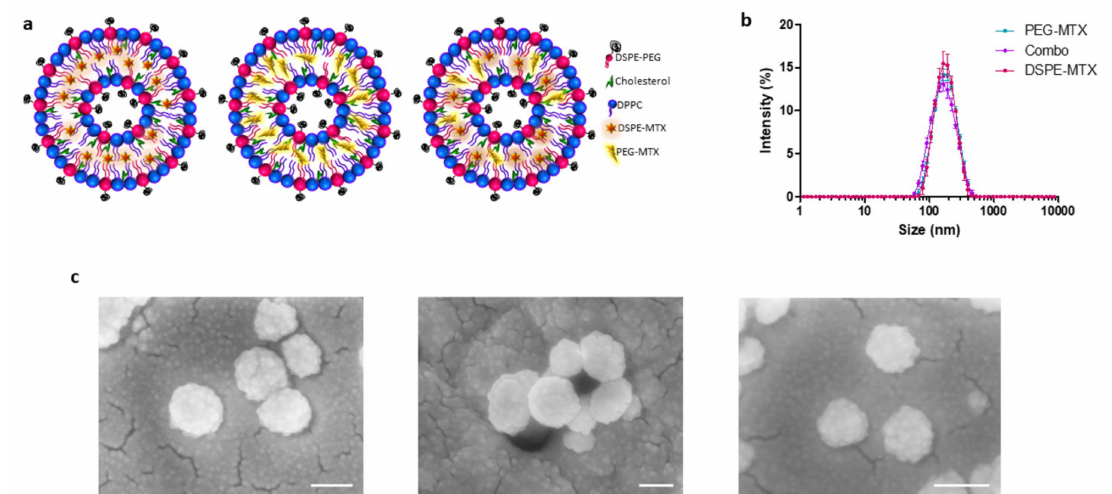
Figure 2. ( a ) Schematic representation of liposomes. ( b ) Hydrodynamic diameter of PEG-MTX-LIP, DSPE-MTX-LIP and Combo-LIP via dynamic light scattering analysis. ( c ) Scanning electron microscopy images of PEG-MTX-LIP, DSPE-MTX-LIP and Combo-LIP, respectively (scale bar: 100